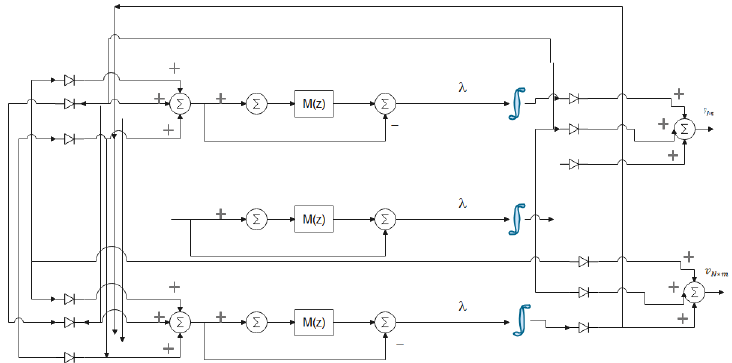
Figure 1. Recurrent neural network (RNN) framework [31].